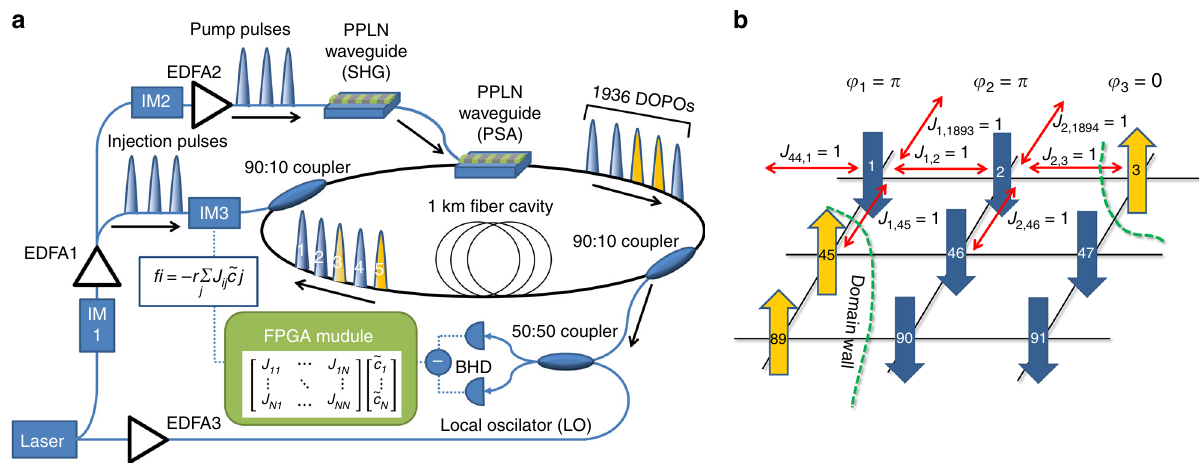
Fig. 1 Experimental setup and exemplary coupling scheme for 2D Ising models. a Schematic of the experimental setup for a coherent Ising machine with an opto-electronic measurement feedback system using 1936 DOPOs. IM intensity modulator, EDFA erbium-doped fi ber ampli fi er, PPLN waveguide poled lithium niobate waveguide, BHD balanced homodyne detection, SHG second harmonic generation, PSA phase-sensitive ampli fi er. b Coupling topology J ij for the ferromagnetic 2D Ising model with 1936 spins implemented in the coherent Ising machine. The spins are indexed using a typewriter ordering with periodic boundary conditions and coupled to their nearest neighbors. Spins are distinguished by the optical phase φ of each DOPO into spin up (yellow, φ = 0) or spin down (blue, φ = π